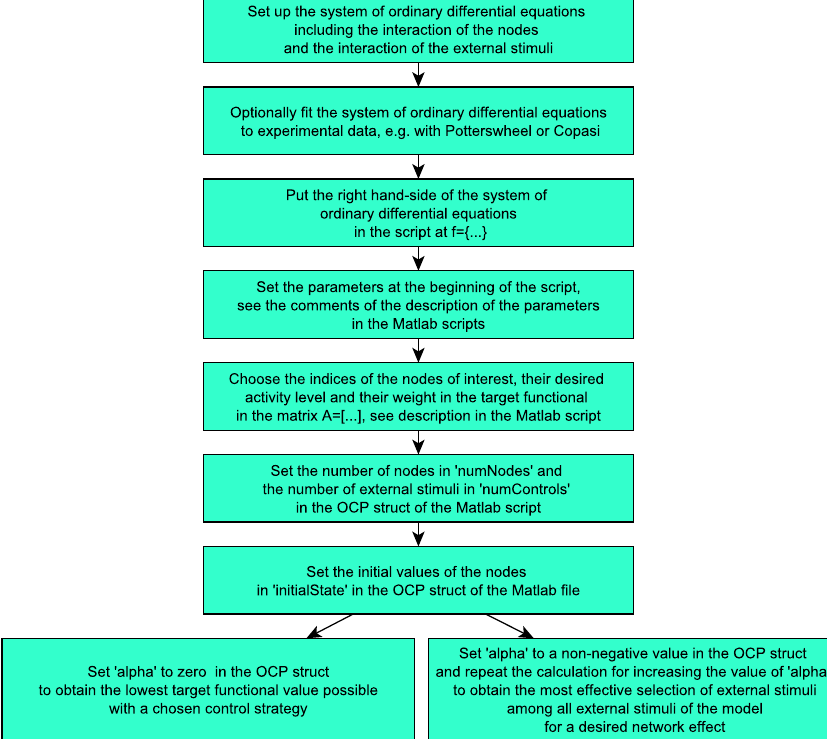
Figure 15. The workflow to use the provided script and the presented framework for the calculation of pharmacological intervention points and the comparison of treatment strategies. See the comments of the Matlab scripts for more details for its use and the setting of the